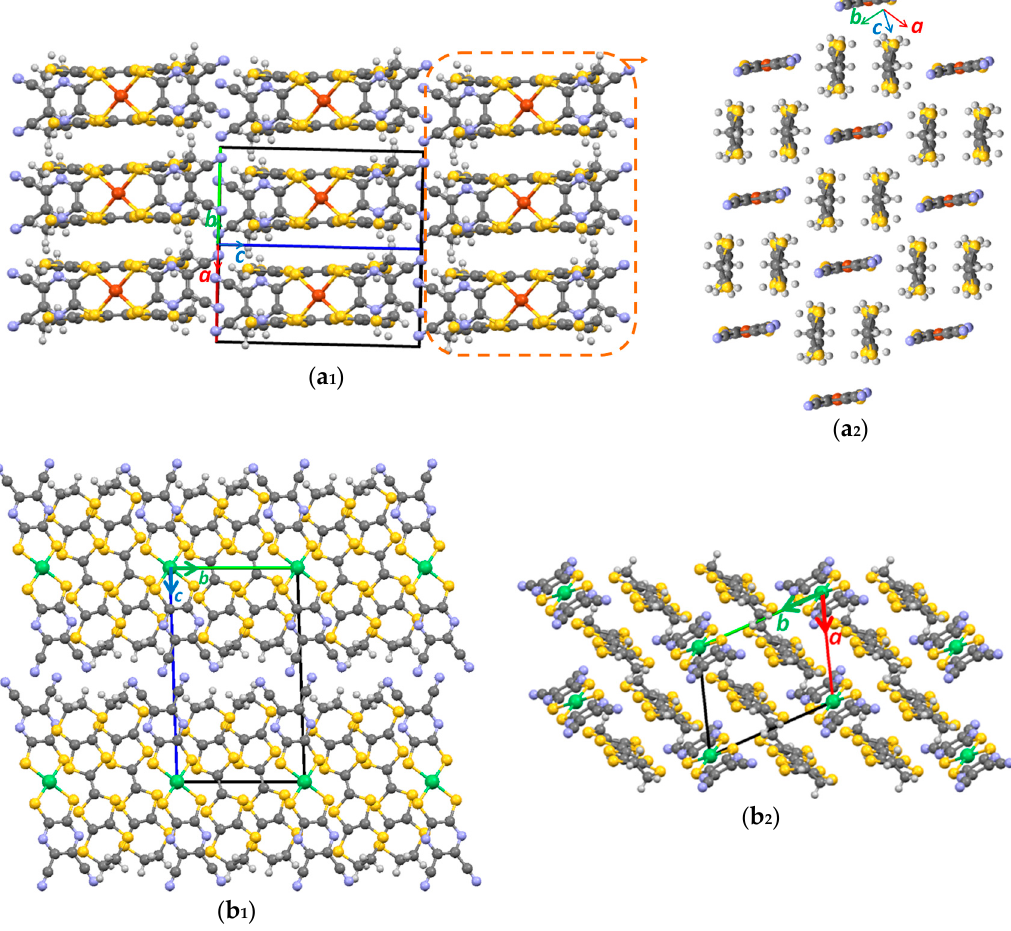
Figure 6. Crystal structure of compound 5 ( a ) and compound 6 ( b ): ( a 1 ) view along a-b ; ( a 2 ) partial view along the long axis of the molecules of neighbouring columns in the same layer, with the alternating dianions and BET-TTF dimers; ( b 1 ) view along the stacking axis; ( b 2 ) partial view of the layers in the ab plane.